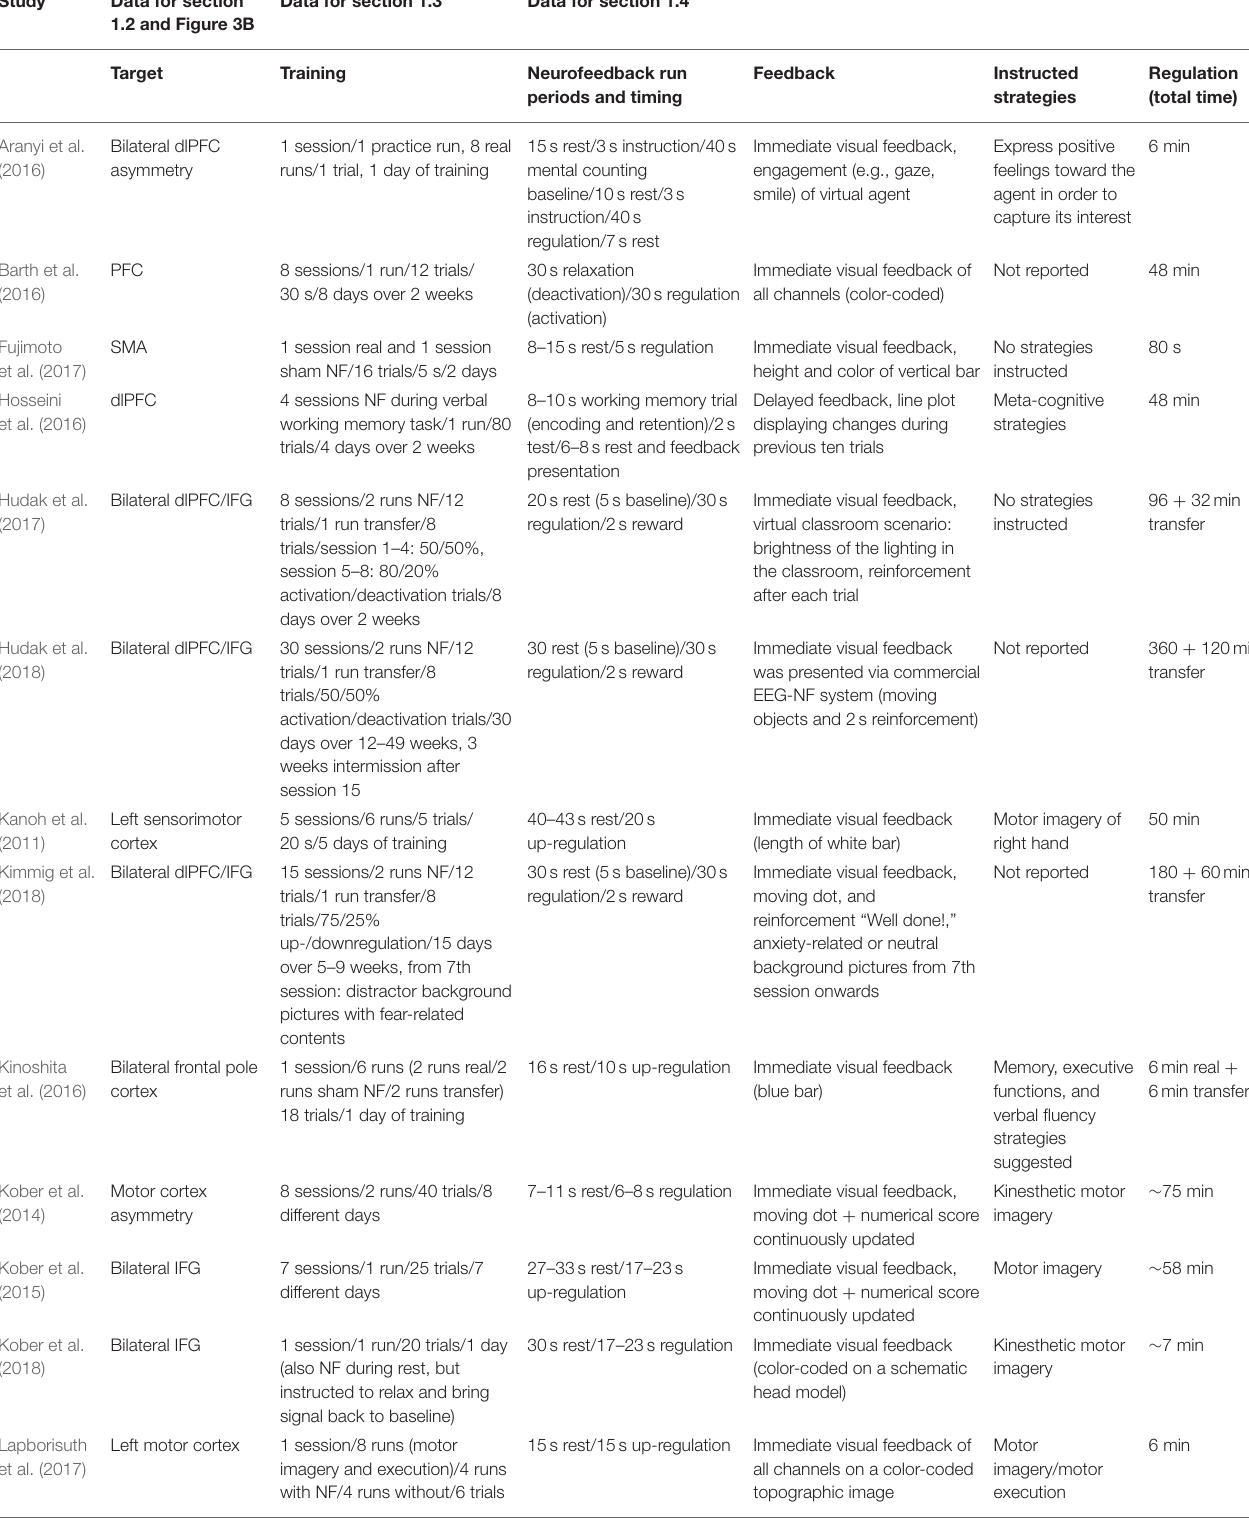
TABLE 1 | Neurofeedback training protocol